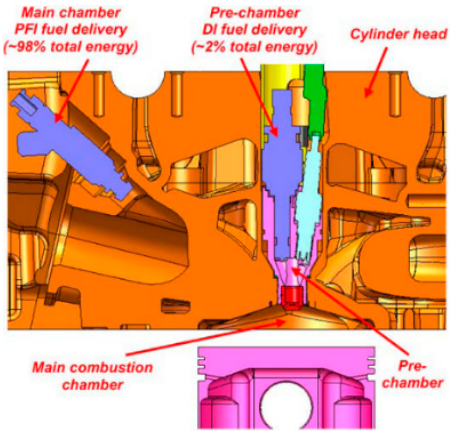
Figure 14. Schematic representation of pre-chamber [261].